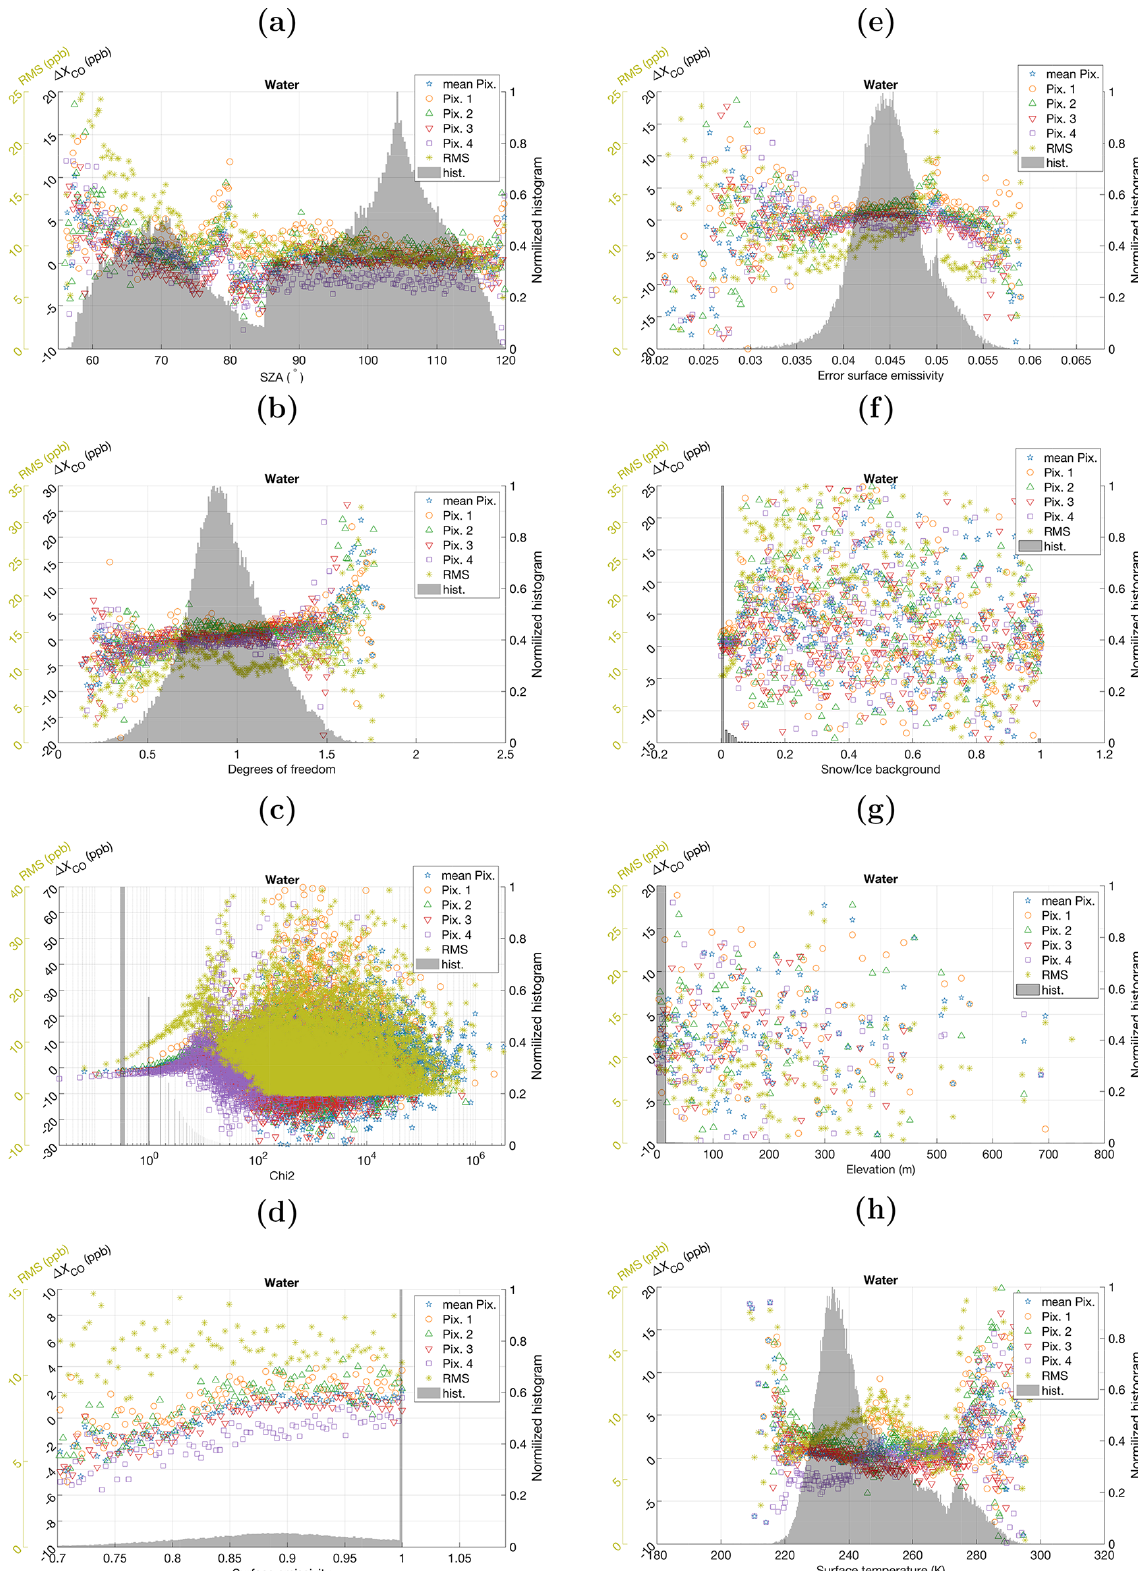
Figure 5. Same as Fig. 4 but for retrievals over